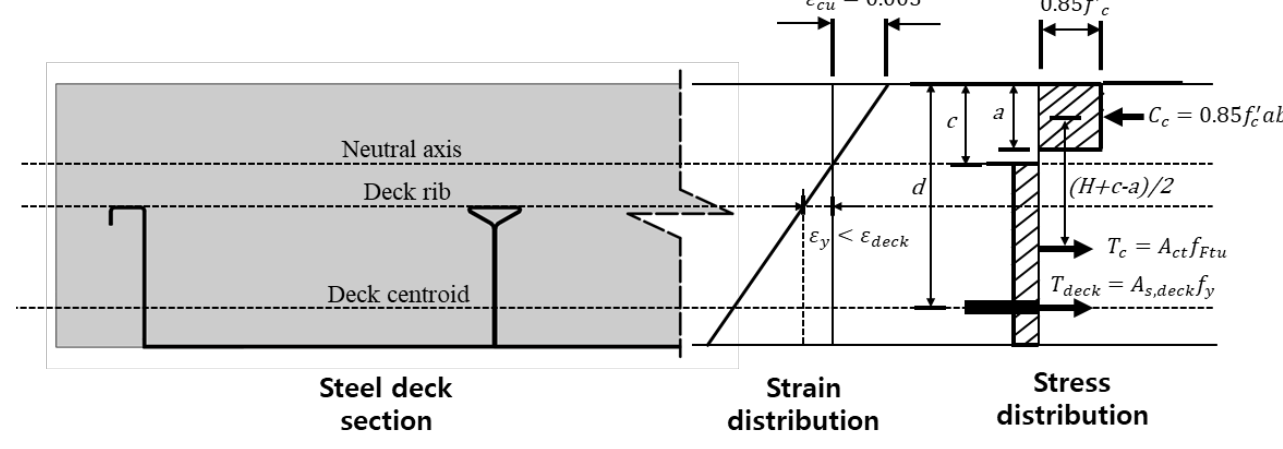
Figure 13. Strain and stress distributions (positive moment).